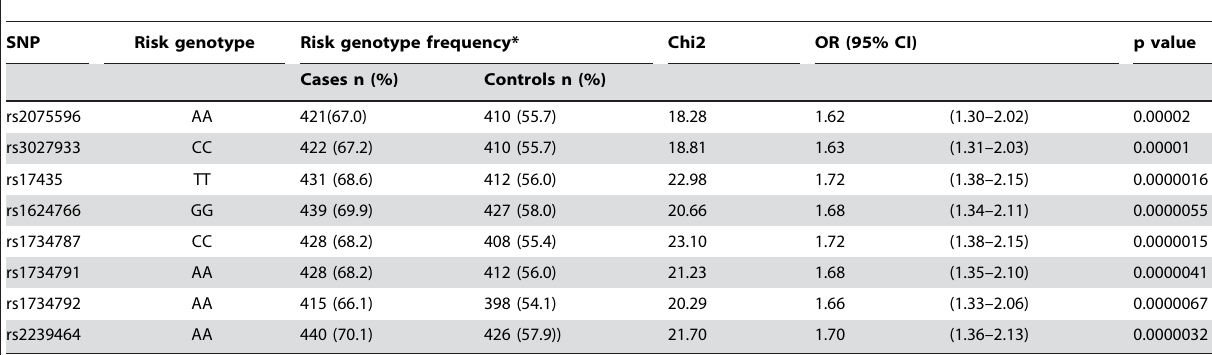
Table 4. Frequencies of homozygous risk allele genotypes in Korean SLE patients compared to controls.